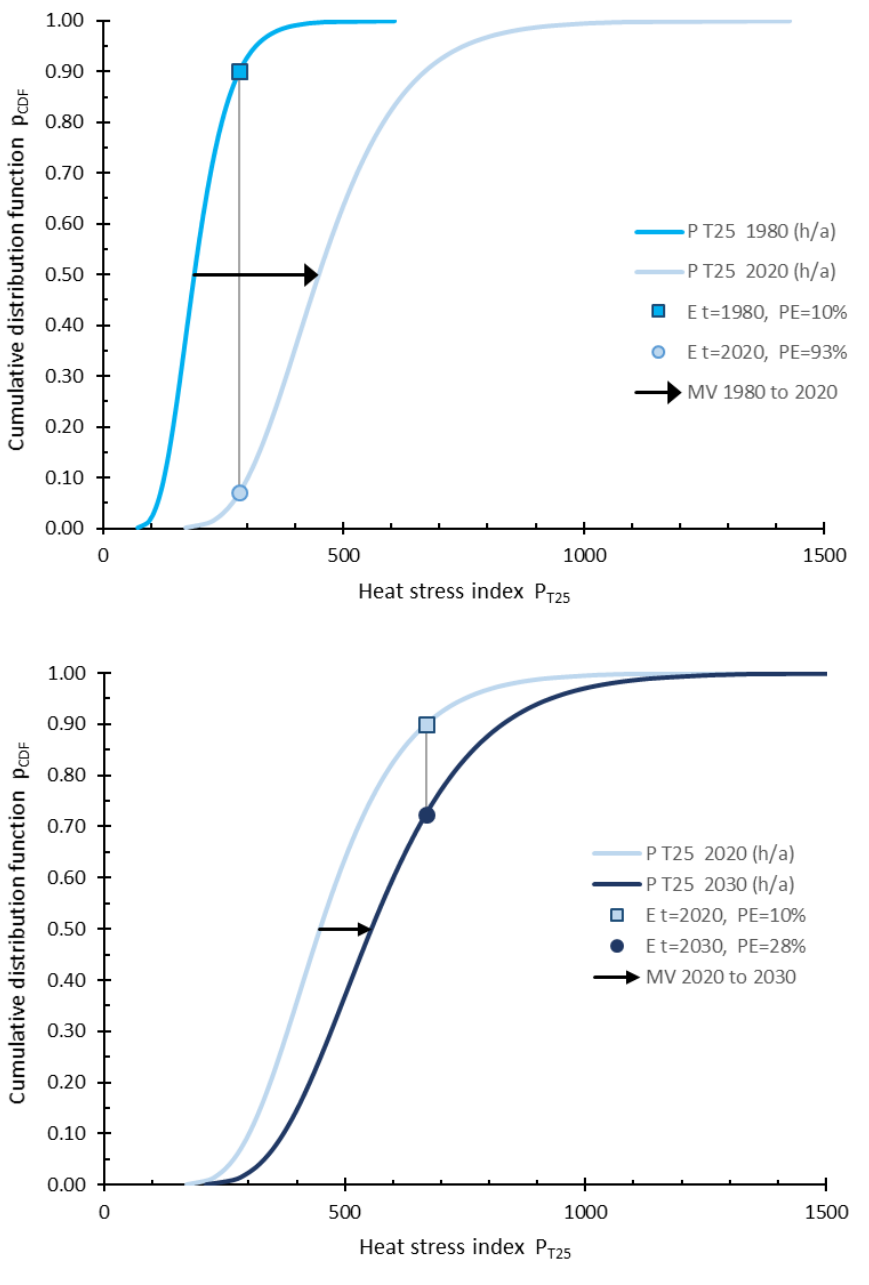
Figure 5. The cumulative distribution function showing the likelihood of the occurrence of P T25 . The shift of the mean value (p CDF = 0.5) is presented by the black arrow. In panel A the scenario of the past (t = 1980 and t = 2020) is shown, and in panel B the scenario of the near future (t = 2020 and t = 2030) is shown.